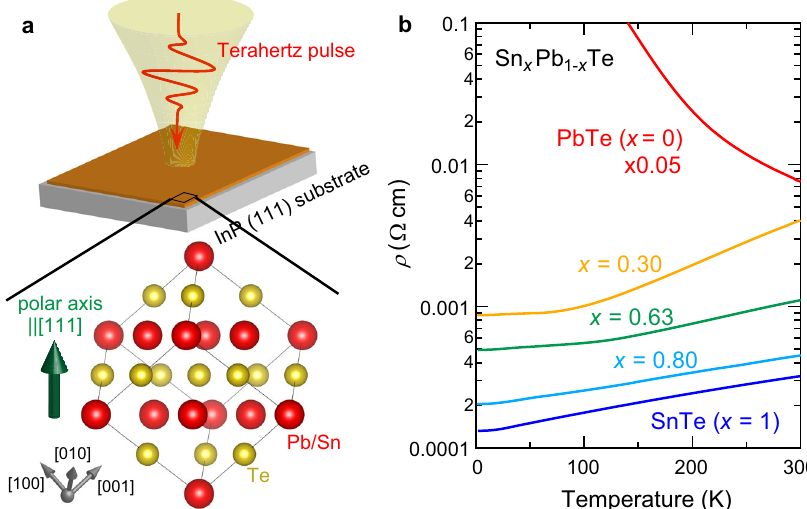
Fig. 1 Crystal structure and transport property of Sn x Pb 1 − x Te thin fi lms. a Crystal structure of Sn x Pb 1 − x Te. The thin fi lm was fabricated on InP (111) substrate. The polar axis along the out-of-plane [111] direction is inferred from the second harmonic generation in the previous study 25 . The terahertz light is incident normal to the plane. b The temperature dependence of the resistivity for Sn x Pb 1 − x Te ( x = 0, 0.30, 0.63, 0.80, the softening with decreasing temperature and then clear hardening for 0.16 ≤ x ≤ 0.80. This observation indicates the robust ferroelectric transition under the presence of conduction elec- trons. The established putative phase diagram suggests the stabilization of the ferroelectricity compared to the bulk system most likely due to the strain from substrate. The low-energy phonon induces the enhanced DC dielectric constant. The enhancement of Born effective charge of TO phonon shows the clear correlation with the band gap closing.